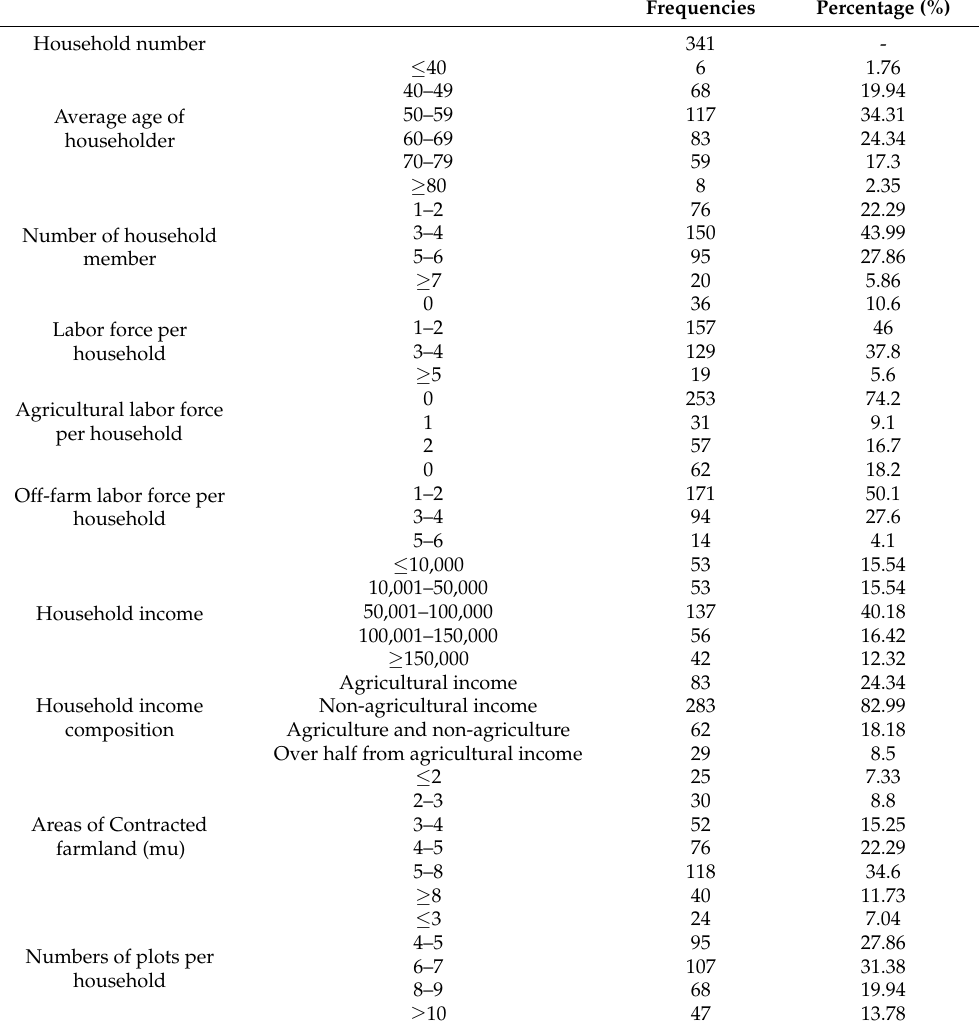
Table 2. Characteristics of rural households in